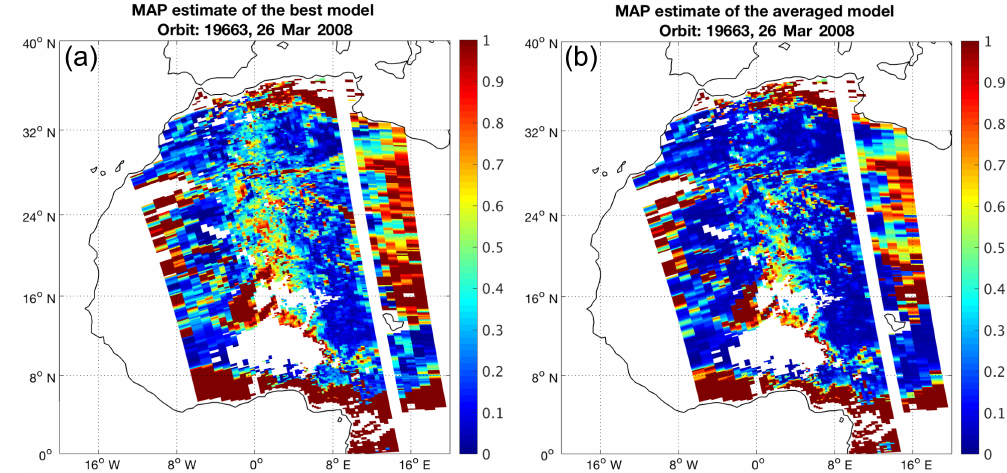
Figure 12. The MAP AOD estimate based on the best model (a) and based on the averaged posterior distribution (b) .